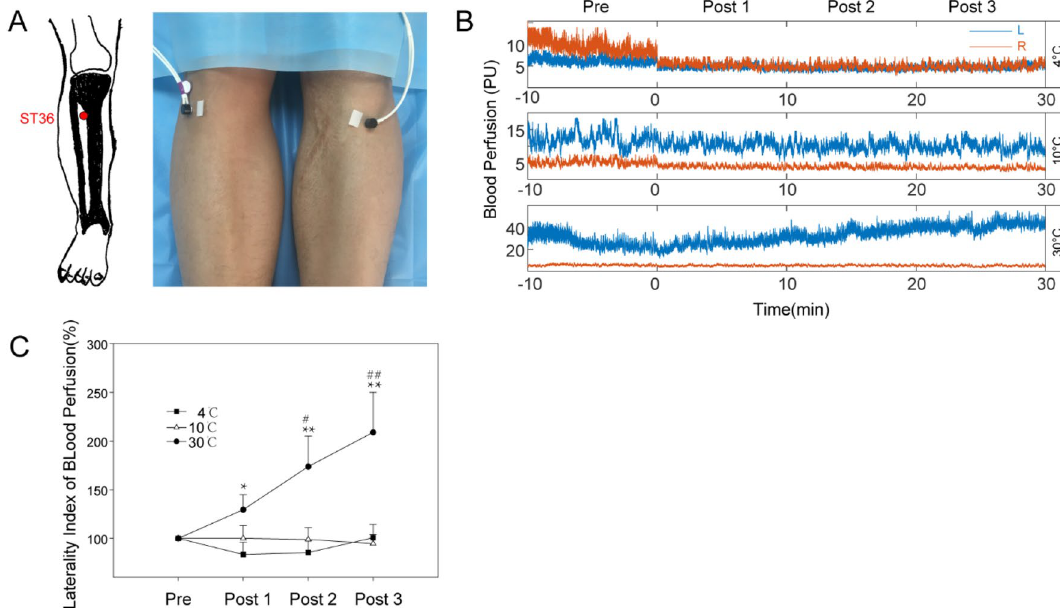
Figure 4. Blood perfusion on both sides. ( A ) Recording position at ST36. ( B ) Raw data of blood flux on both sides; ( C ) Laterality index of blood perfusion. * P corr < 0.05, ** P corr < 0.01 (4 °C vs. 30 °C); # P corr < 0.05; ## P corr < 0.01 (10 °C vs. 30 °C); P corr : corrected P value. All values are reported as the mean ± standard error.